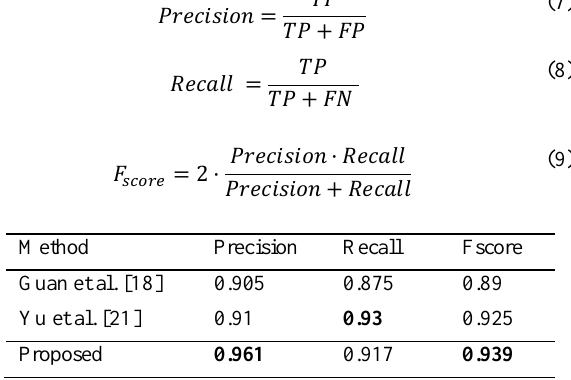
Table 1. Results for road marking